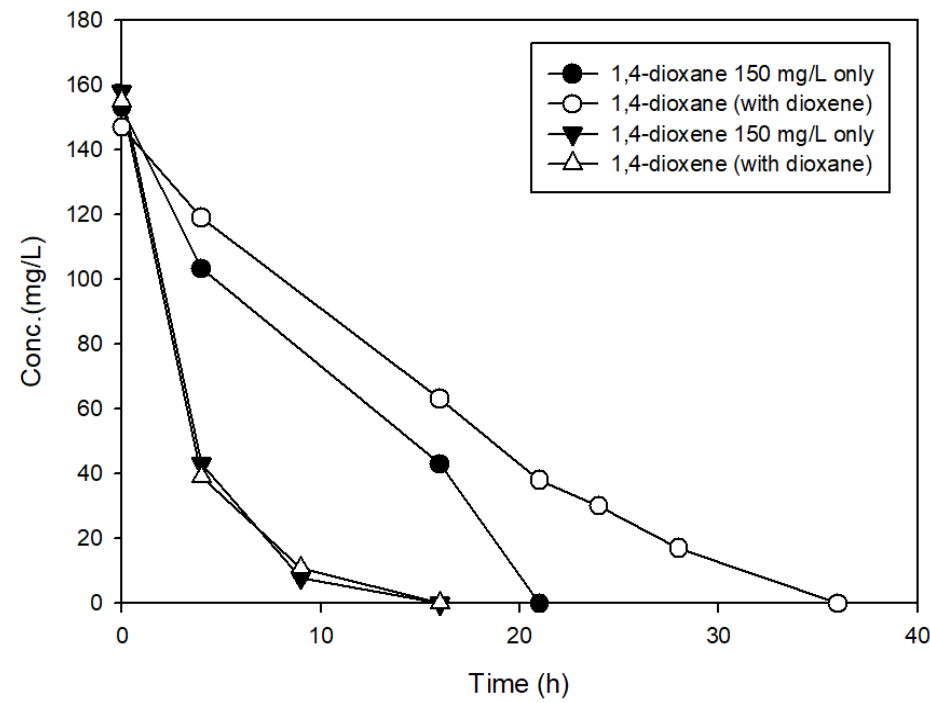
Figure 12. Biodegradation of 1,4-dioxane in the presence of 1,4-dioxene.